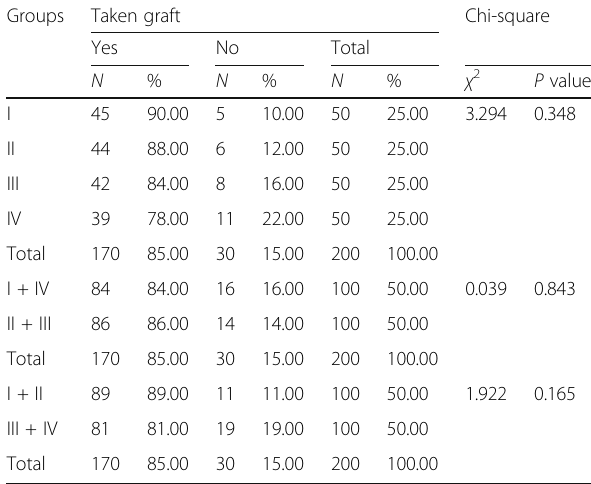
Table 3 The comparison as regards graft taking between study groups Groups Taken graft Chi-square